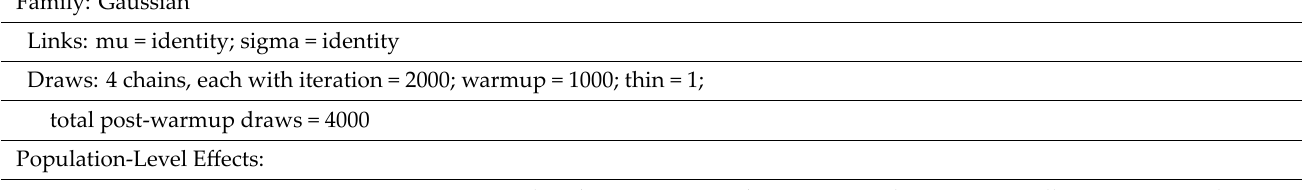
Table 2. Output from Bayesian regression model fitting using the brms R package [53–55], as copied‑ pasted from the R system with minor customisation. The variables b1, b2 and b3 correspond to β β β 2 and 3 of the model. mu and sigma are the hyperparameters of the Gaussian distribution, 1 , respectively, corresponding to the estimate of the response variable y and standard deviation of the estimate (i.e., noise indicated in the